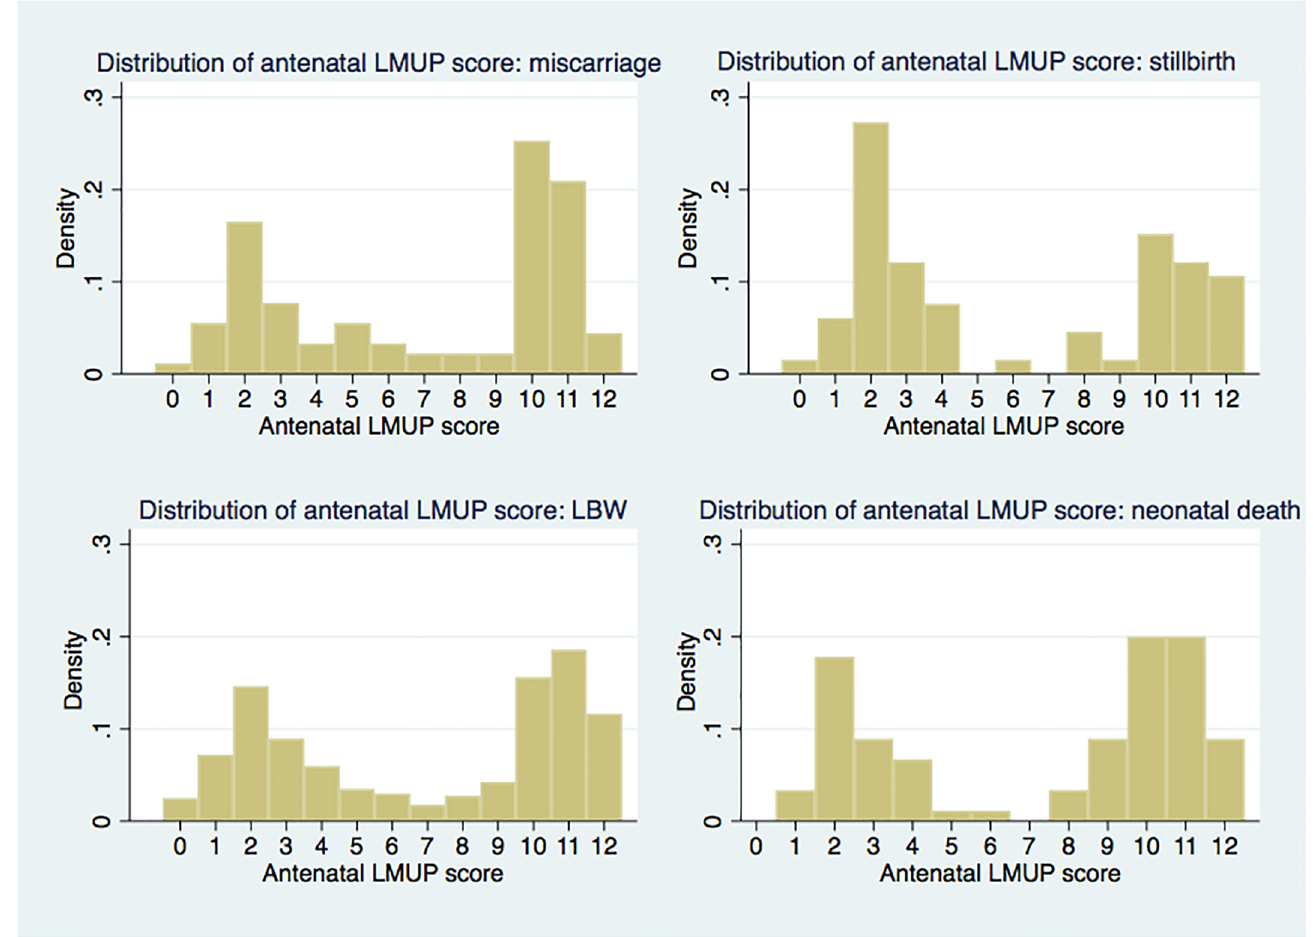
Fig 3. Distribution of antenatal LMUP score by miscarriage, stillbirth, low birthweight and neonatal death.